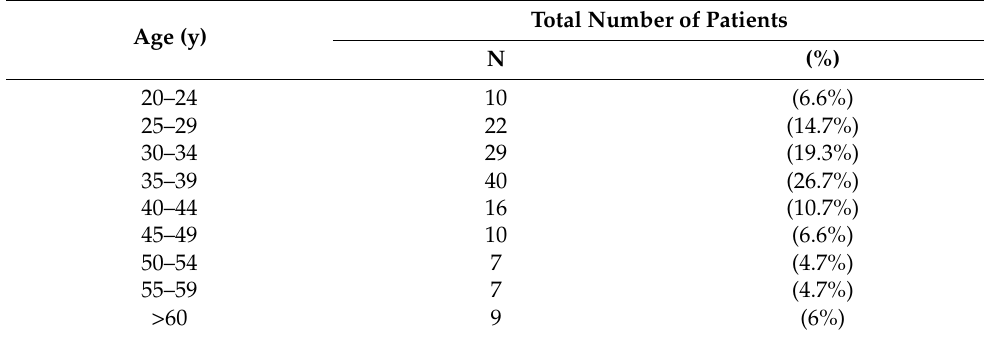
Table 1. Age distribution of patients